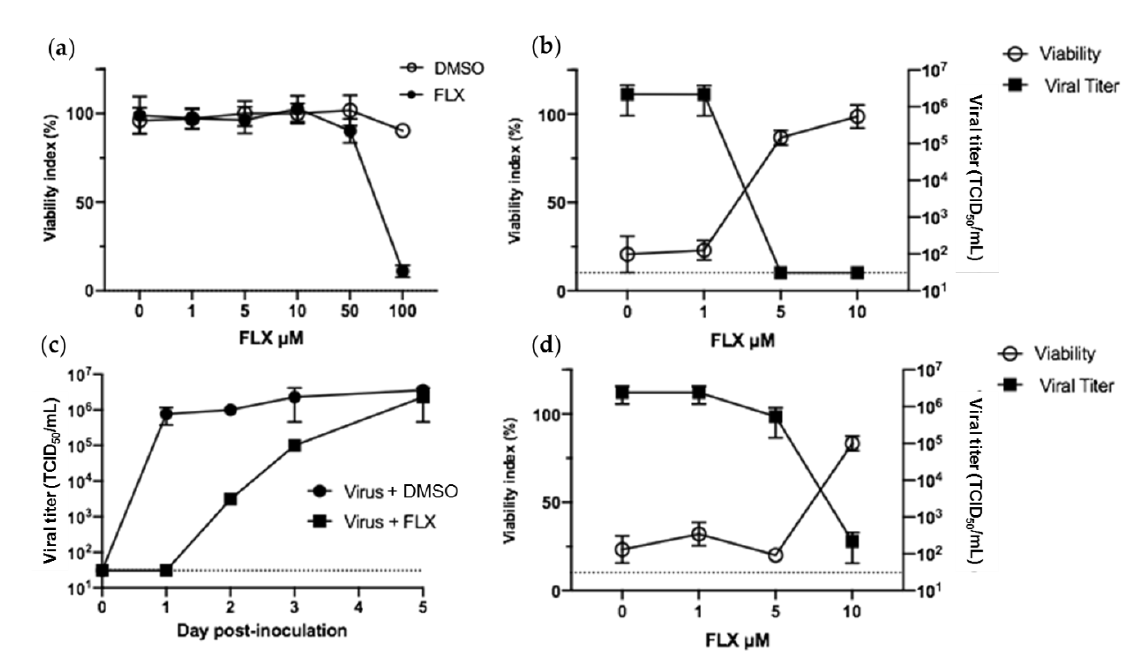
Figure 1. Fluoxetine (FLX) can inhibit the replication of severe acute respiratory syndrome coronavirus 2 (SARS-CoV-2) and CV-B4 E2 in Vero E6 cells. Vero E6 cells were seeded in 24-well plates at 10 5 cells per well. ( a ) DMSO or various concentrations of FLX dissolved in DMSO were added to cell cultures to determine the cytotoxic concentrations. Cell viability was assessed using the Orangu assay after 72 h. Optical density values are normalized using the viability value of uninfected cells (mock = 100%). ( b ) Vero E6 cells were inoculated with CV-B4 E2 at MOI 0.01 and various concentrations of FLX dissolved in DMSO were added to cell cultures at non-cytotoxic concentrations; the cells were washed 2 h post- inoculation (DMSO conditions not shown). ( c ) Cell cultures were inoculated with SARS-CoV-2 at MOI 0.01 and 10 μM of FLX; cells were washed 2 h post-inoculation. ( d ) Vero E6 cells were inoculated with SARS-CoV-2 at MOI 0.01 and various concentrations of FLX dissolved in DMSO at non-cytotoxic concentrations. The cells were washed 2 h post-inoculation, and either FLX was added at the same concentration or DMSO (DMSO conditions not shown). Day 2 post-infection, cell viability was expressed as % compared with uninfected FLX-treated cells and levels of infectious particles were deter- mined using the endpoint dilution assay. The Spearman–Karber method was used to determine the tissue culture 50% infectious dose (TCID 50 /mL). The results are expressed as the mean ± SD of three independent experiments.